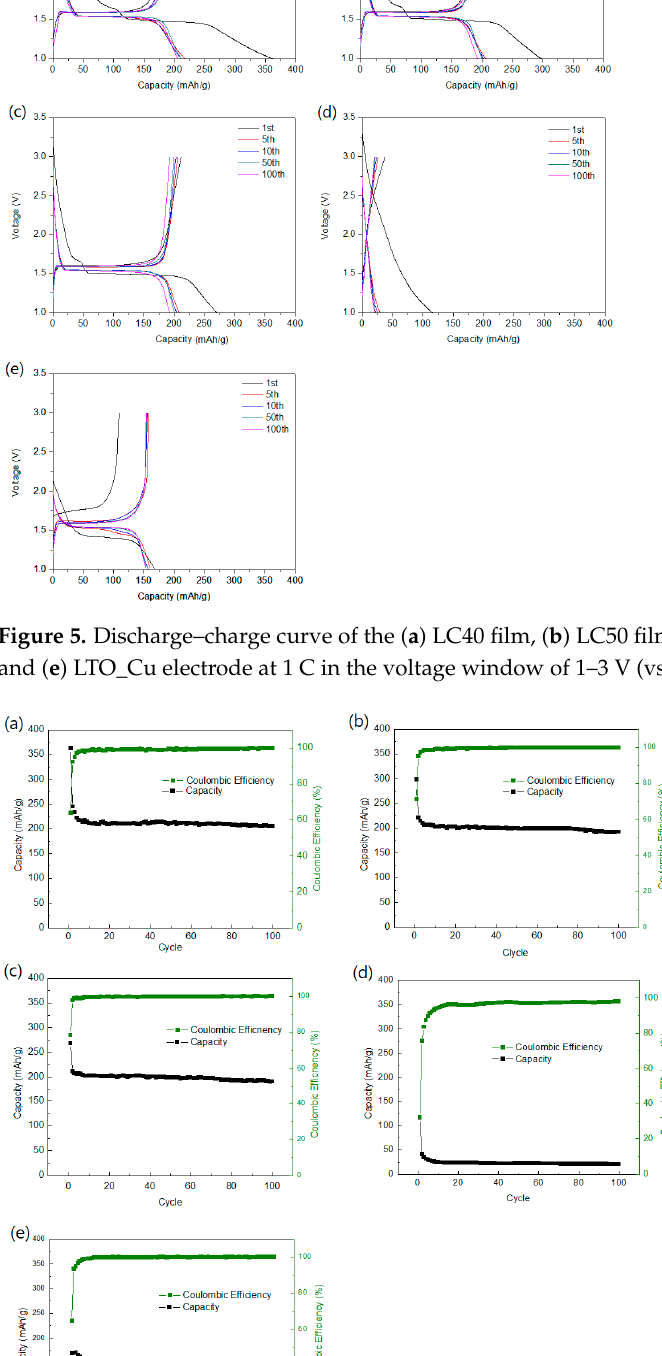
Figure 7. Nyquist impedance plots of the LC40, LC50, LC60 films, and LTO_Cu electrodes after ( a ) making cell and ( b ) 20th charge at 0.5 C, measured in the frequency range of 0.01 Hz–1 MHz (Z’: real part of impedance; Z’’: imaginary part of impedance). Table 1. Physical properties and electrochemical impedance spectroscopy parameters of the LC films and LTO_Cu electrodes. LC40